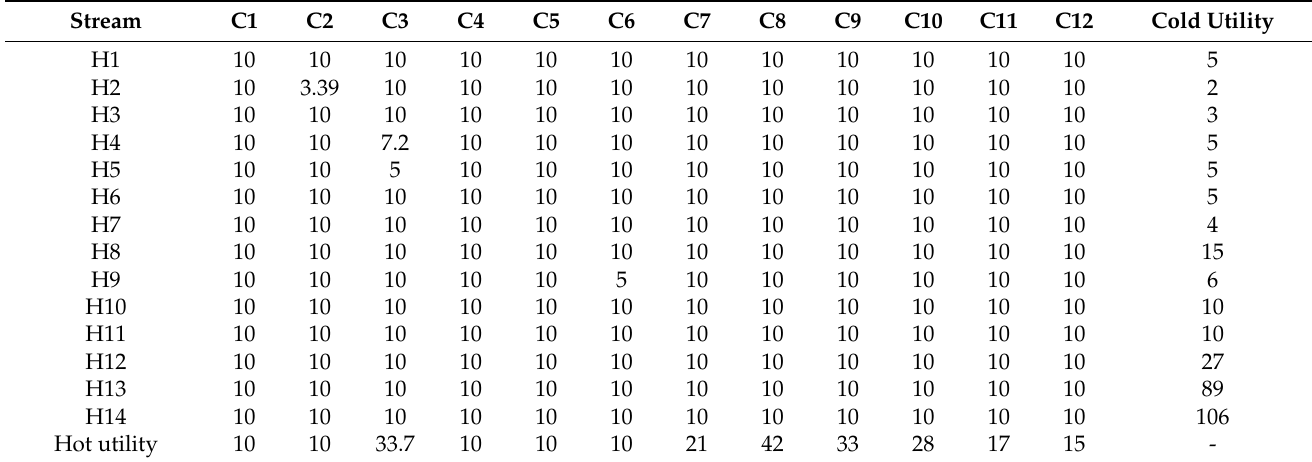
Table 4. Minimum temperature differences ( ◦ C) for different